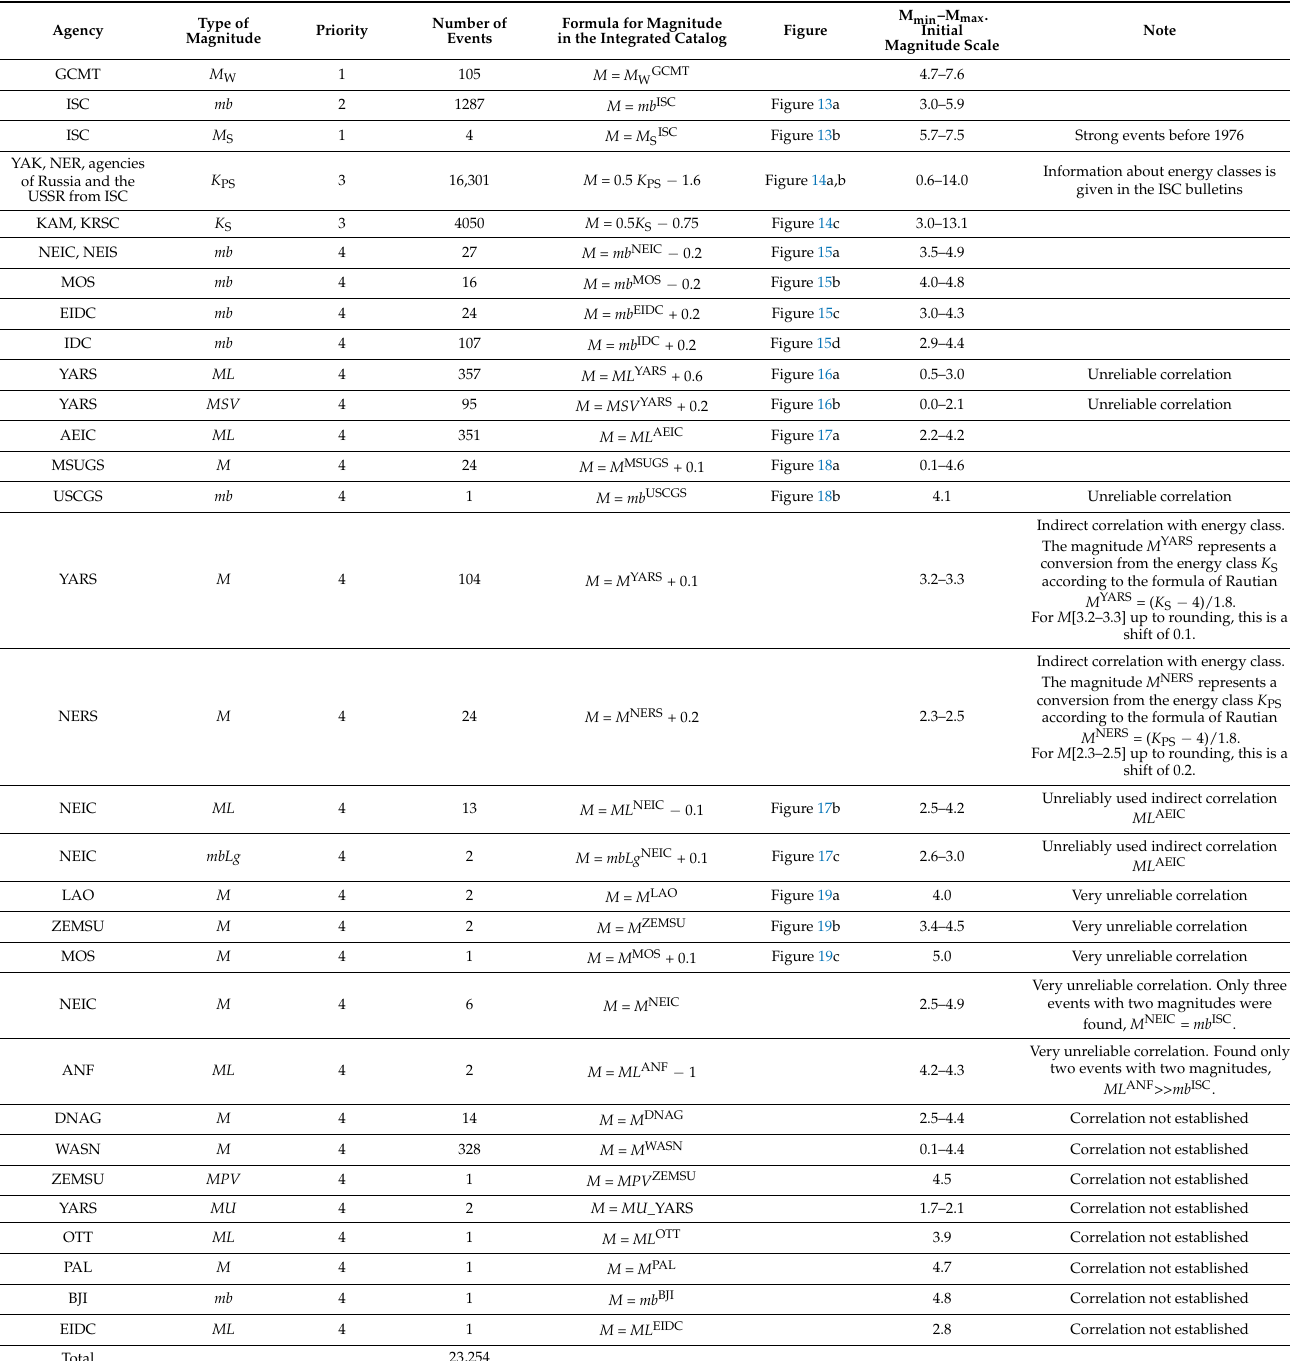
Table 4. Magnitudes in the unified catalog of the Eastern Sector of the Russian